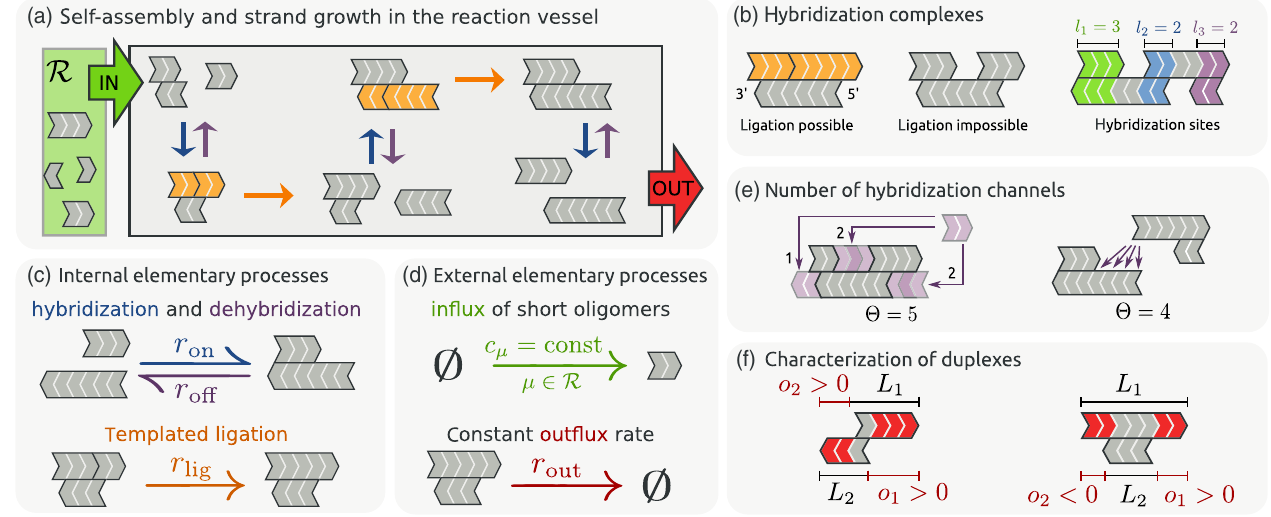
FIG. 2. (a) Short strands entering the reaction vessel from the reservoir are the initial building blocks of the system. Inside the vessel, strands form various complexes via hybridization and dehybridization. Subsequent ligation leads to longer strands eventually leaving the system. (b) Examples of higher-order complexes with multiple hybridiziation sites. (c) The internal elementary processes are hybridization, dehybridization, and templated ligation with corresponding rates r couple the system to its environment. Short strands of length L ¼ μ for μ ∈ R are chemostated via the coupling to an external reservoir of initial building blocks at fixed concentrations c μ . All complexes leave the system at a constant rate r collide, they can form Θ different hybridization complexes. (f) Duplexes D ≔ ð L 1 ; L 2 ; o 1 Þ are uniquely characterized by the strand lengths L 1 ; L 2 ∈ N and one of the overhangs o i ∈ Z of strand S i , i ∈ f 1 ; 2 g , at its 3 0 end. Overhangs o i can be negative, as for the case of o 2 in the right-hand